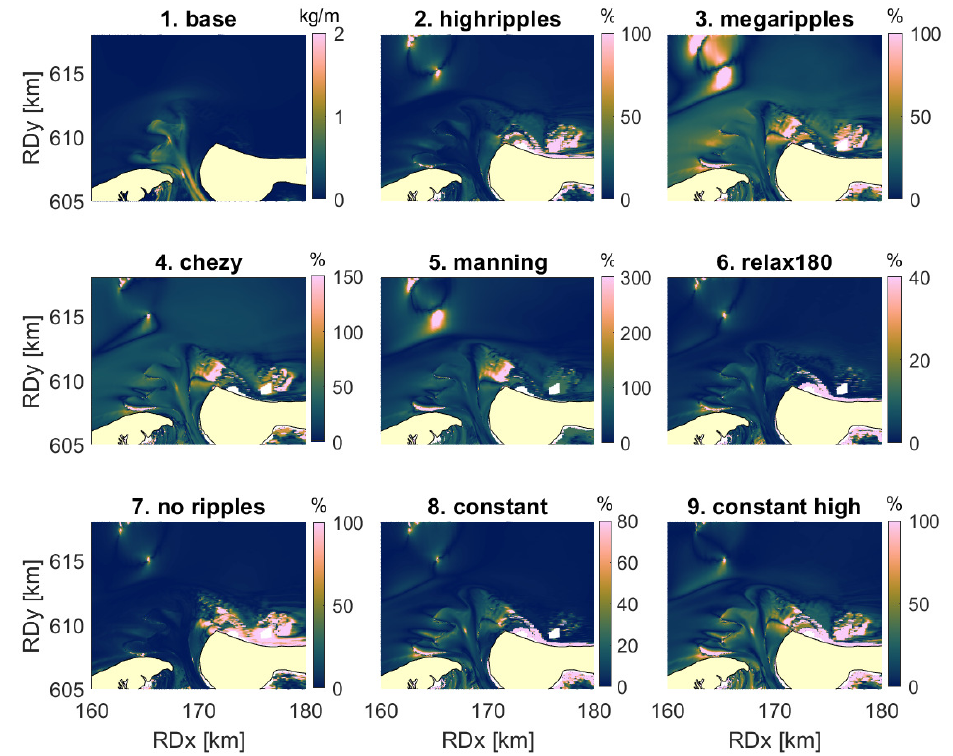
Figure 11. Time-integrated bedload transport q b during calm weather (1), and absolute relative difference in q b of all other scenarios with the base scenario during calm weather